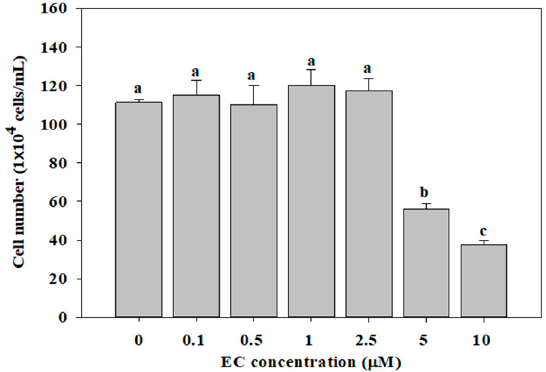
Figure 2. E ff ects of erinacine C (EC) on cell growth in BV2 microglial cells. Cells were treated with di ff erent concentrations of EC (0.1–10 µ M) for 24 h. Cell numbers were counted using a hemocytometer. Values (means ± SD, n = 3) not sharing a common lower case letter are significantly di ff erent ( p < 0.05).